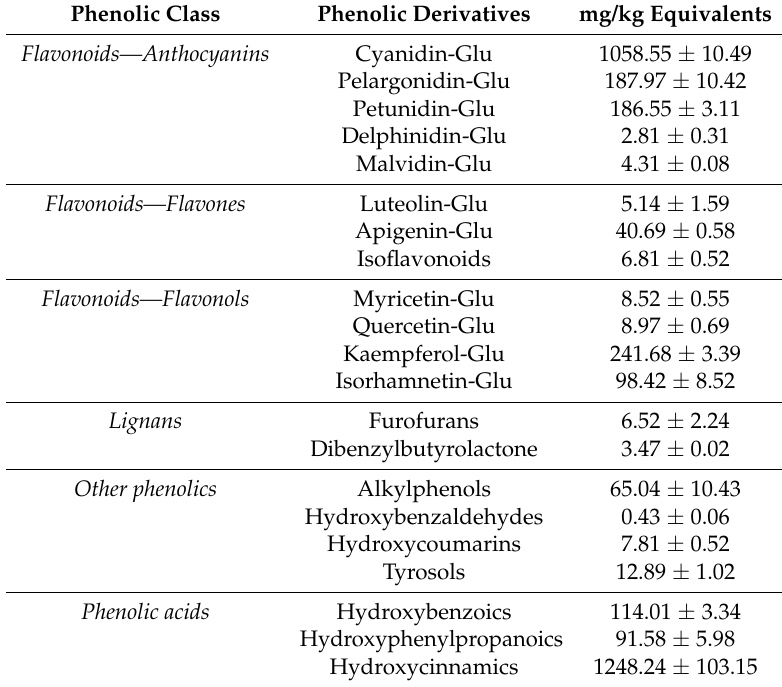
Table 3. Quantifications per classes of phenolics identified from untargeted UHPLC-ESI-QTOF-MS in Ficodindia di San Cono PDO cladodes. Results are expressed in mg/kg of phenolic equivalents. The data are presented as mean values ± standard deviation ( n = 3). Glu =